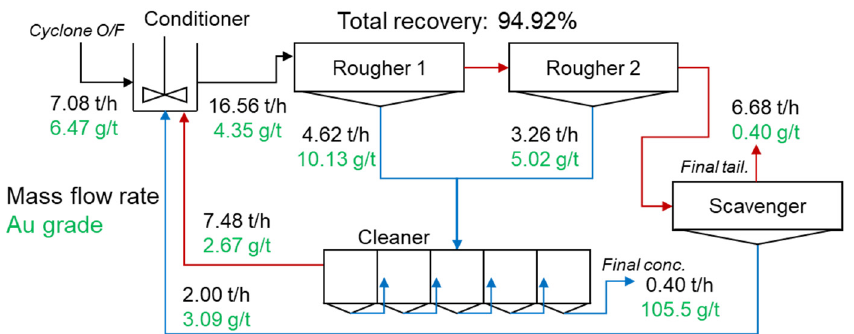
Figure 8. Simulated mass balance of current circuit of gold ore flotation. Blue line represents stream of floated products, and red line represents stream of sinked products after flotation. Black text is the mass flow rate. Green text is the gold grade at each node.